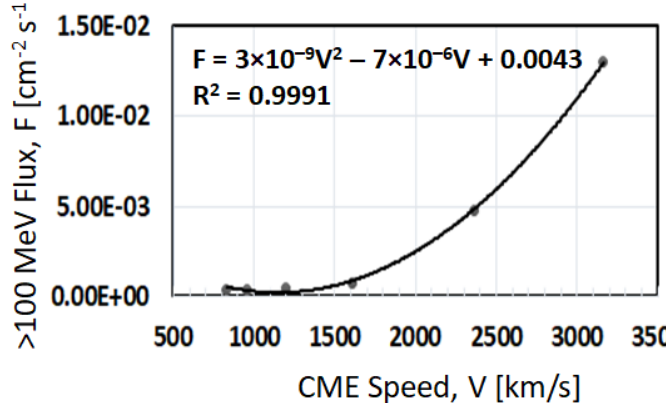
Figure 6. Scatter plot between > 100 MeV gamma-ray flux (F) from Fermi / LAT against the CME speed